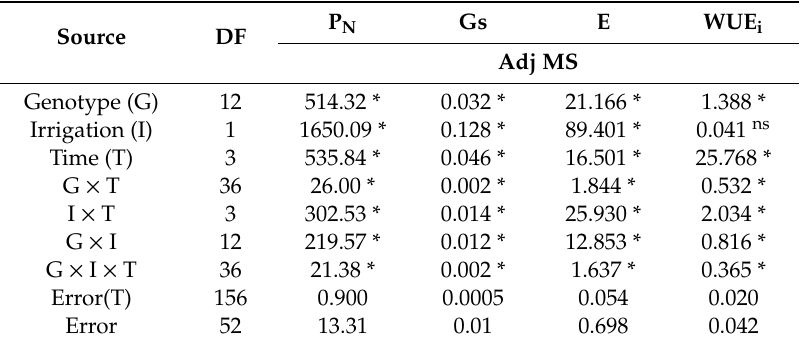
Table 3. Repeated measures ANOVA for main e ff ects and interactions on gas exchange parameters (net photosynthesis—P N , stomatal conductance—Gs, transpiration rate—E, and instantaneous water